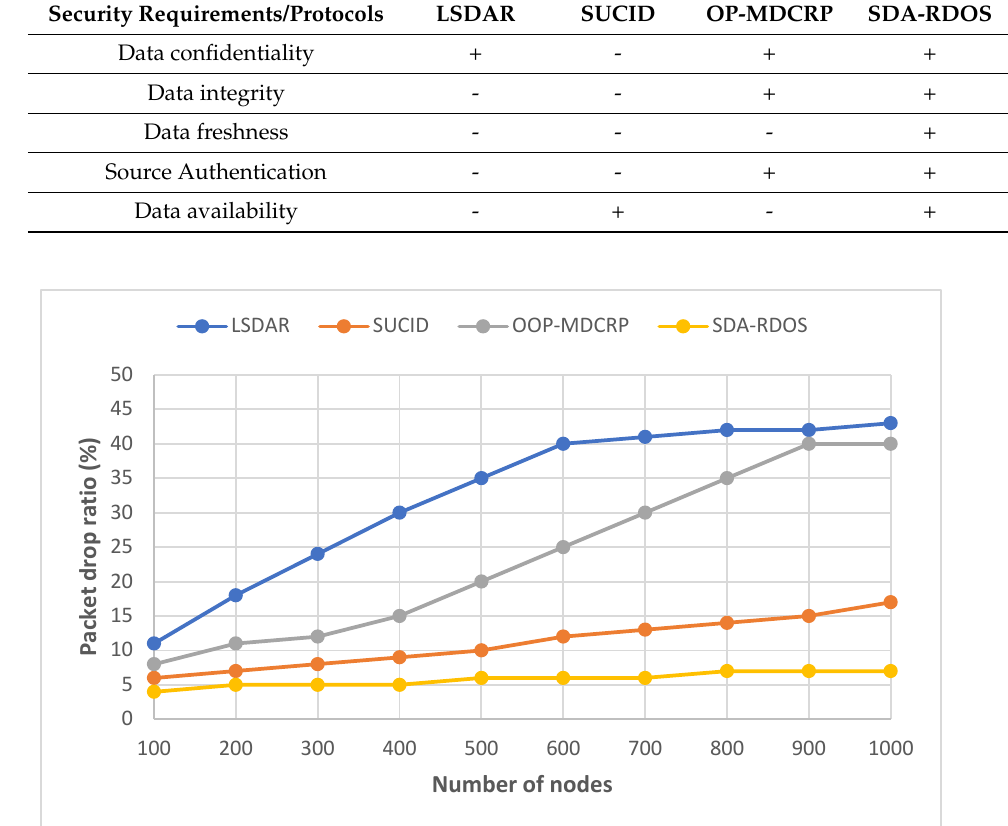
Figure 20. Security Analysis of LSDAR, SUCID, OOP ‐ MDCRP, and SDA ‐ RDOS protocols.